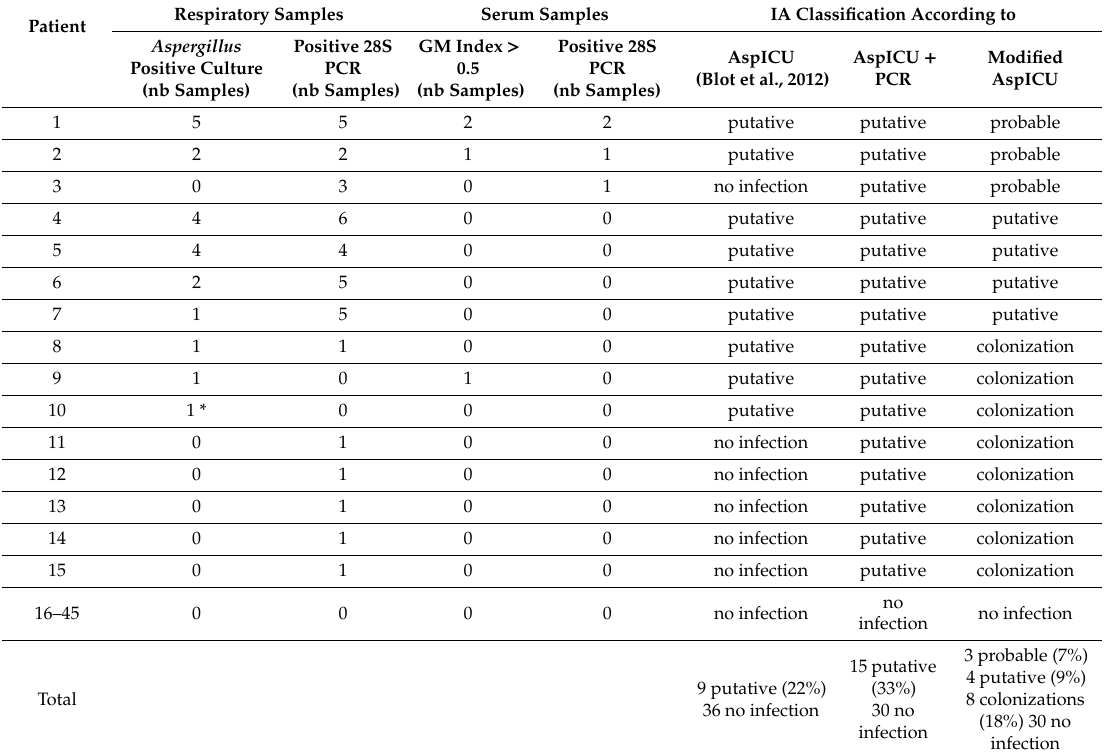
Table 6. Mycological results and classification of 45 COVID-19 patients with